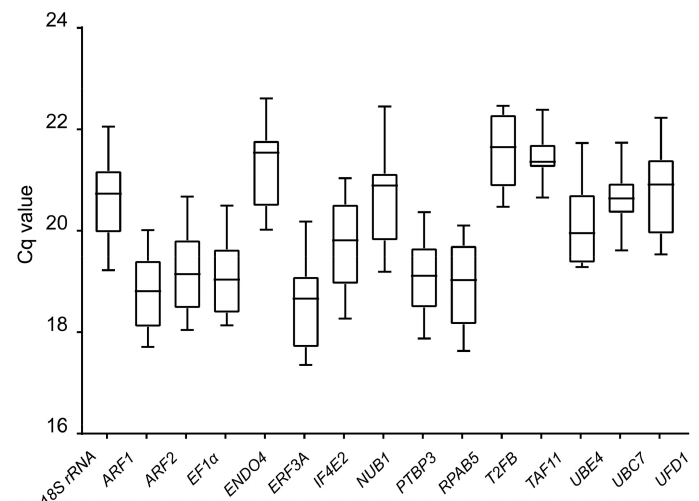
Figure 2. Cq (quantification cycle) values of the 15 candidate reference genes across all samples. The final Cq value of each cotton sample was the mean of three biological and technical replicates. Box graph indicates the interquartile range. A line across the box represents the median. Whisker caps represent the maximum and minimum values.